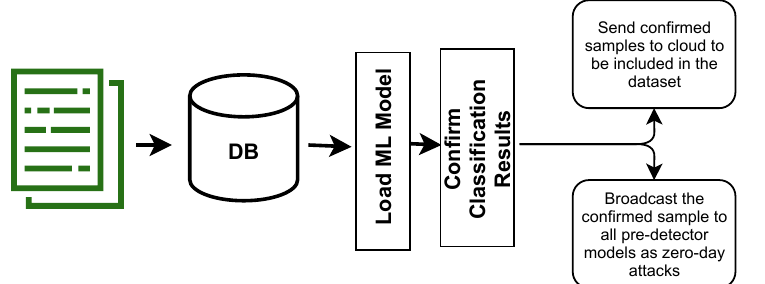
Figure 7. Workflow of the Fog Layer in the Proposed